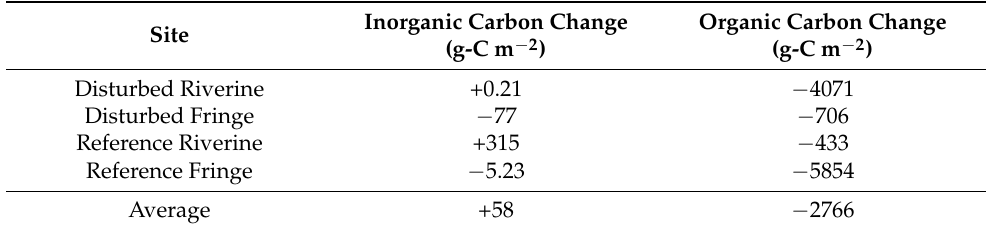
Table 2. Carbon gained (+) or lost ( − ) between 2013–2014 and 2019 sampling in the top 20 cm of soil in the disturbed and reference creeks.